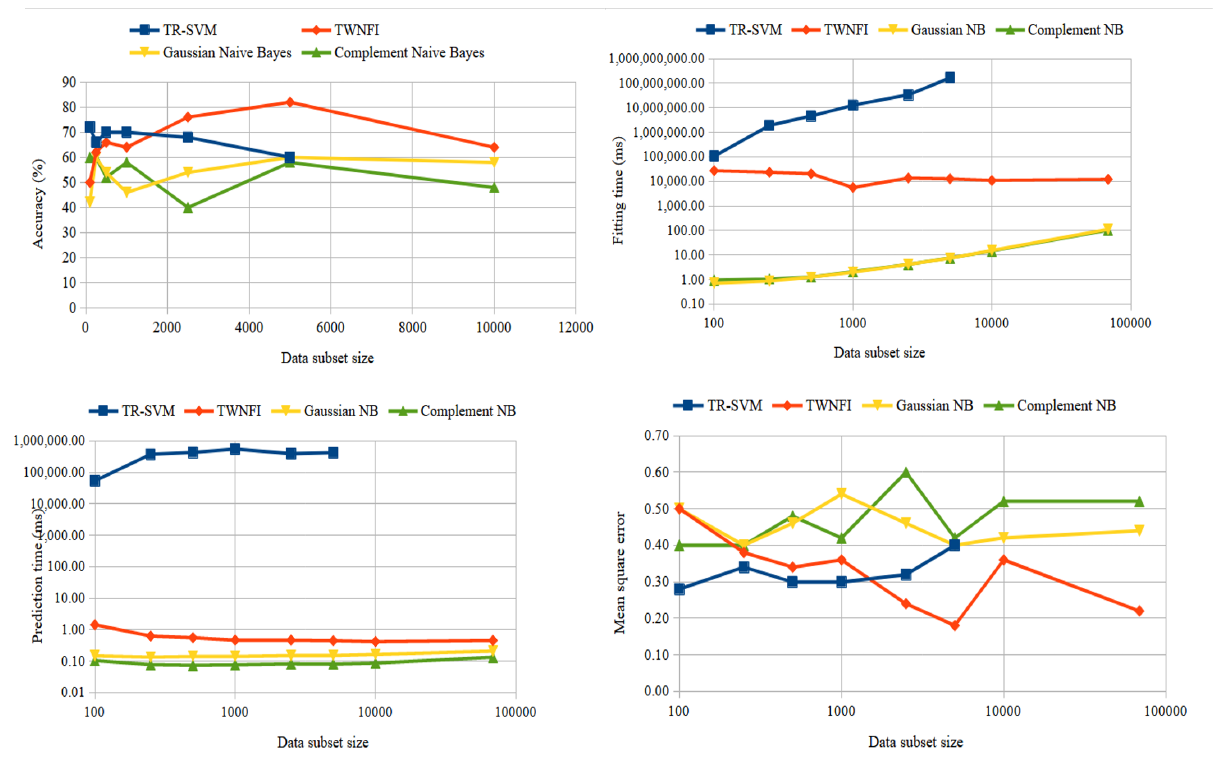
Figure 7. Comparison of accuracy, fitting time, prediction time and mean square error between the chosen